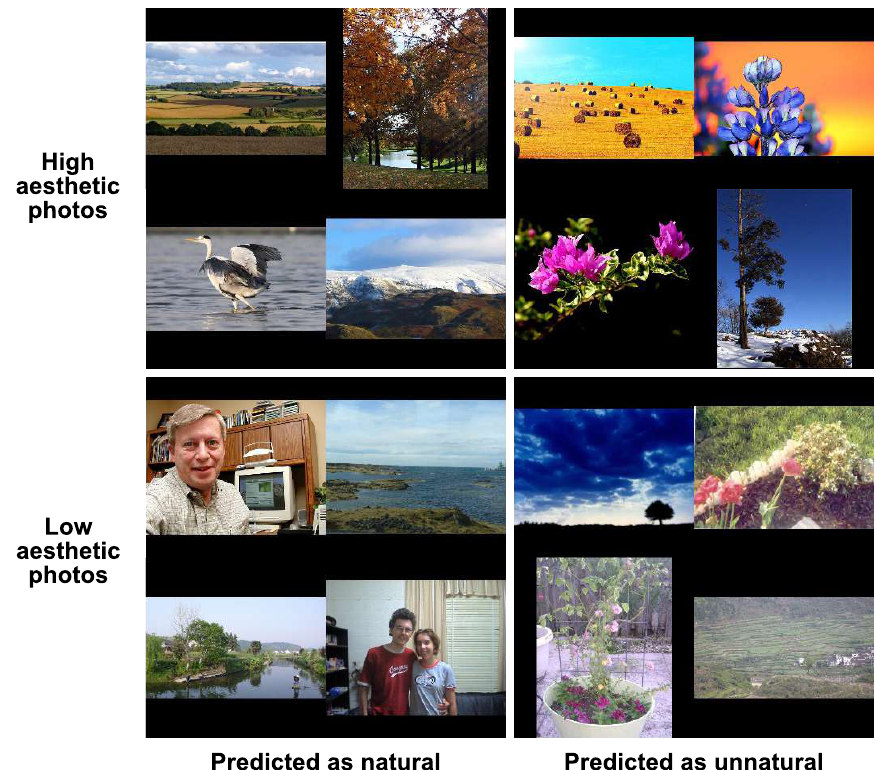
Figure 11. INA samples of high and low aesthetic